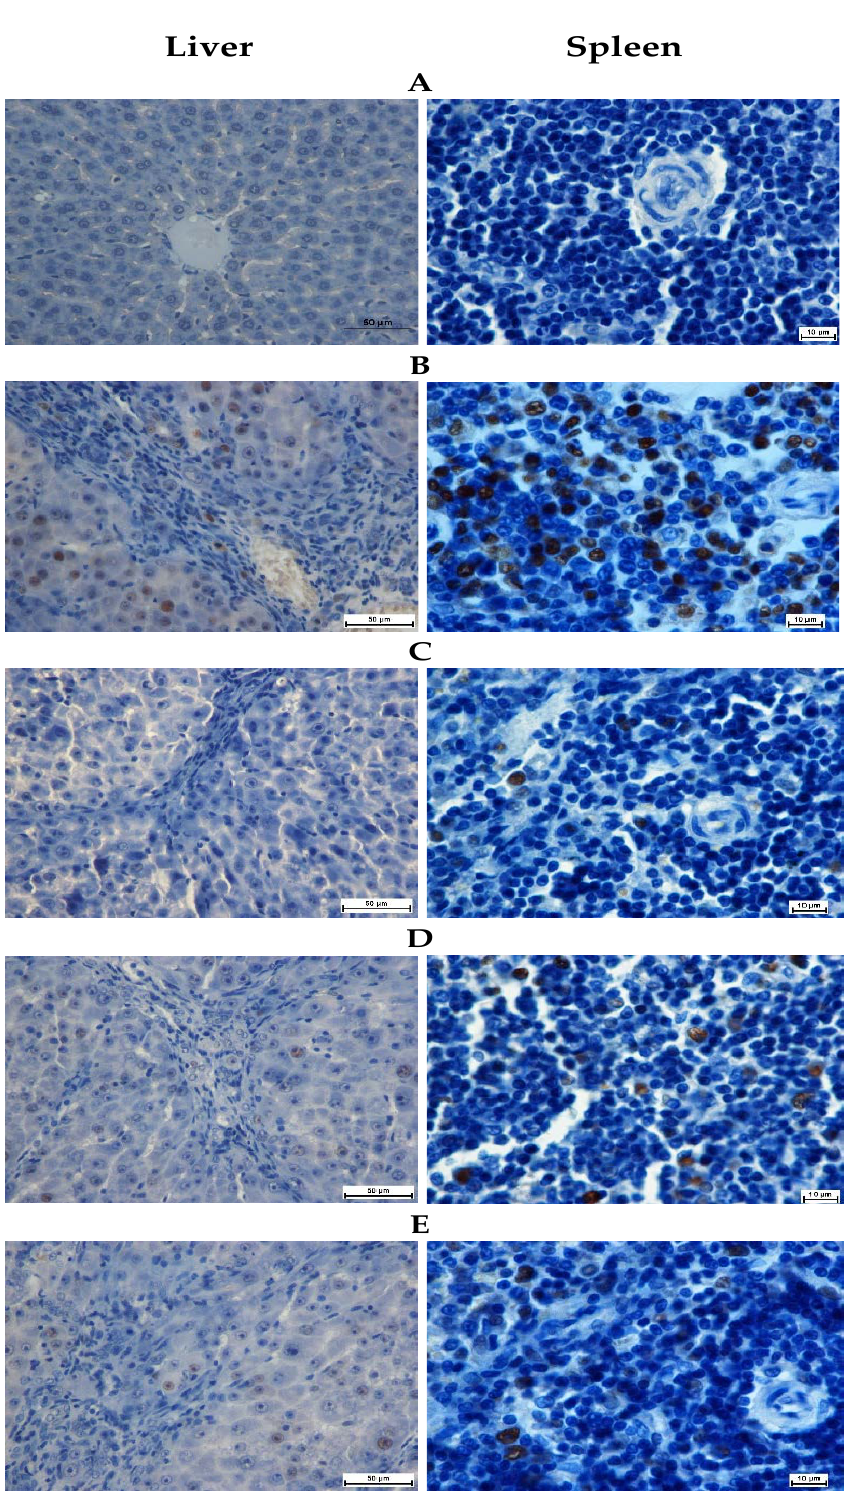
Figure 3. Immunohistochemistry stain (PCNA) of liver and spleen. Impacts of A. muricata extract on thioacetamide-induced liver and spleen injuries in experimental rats. ( A ) Normal control group, no PCNA staining (downregulation); ( B ) rats treated with thioacetamide (hepatotoxic group), PCNA expression hepatocyte nuclei (up-regulation); ( C ) rats treated with thioacetamide + silymarin, mild PCNA expression of hepatocytes nuclei (down-regulation); ( D ) rats treated with thioacetamide + 250 mg/kg A. muricata , mild to moderate expression PCNA-positive hepatocyte nuclei (down-regu- lation); and ( E ) rats treated with thioacetamide + 500 mg/kg A. muricata mild PCNA expression hepatocyte nuclei (down-regulation) (PCNA stain, magnification 40x).